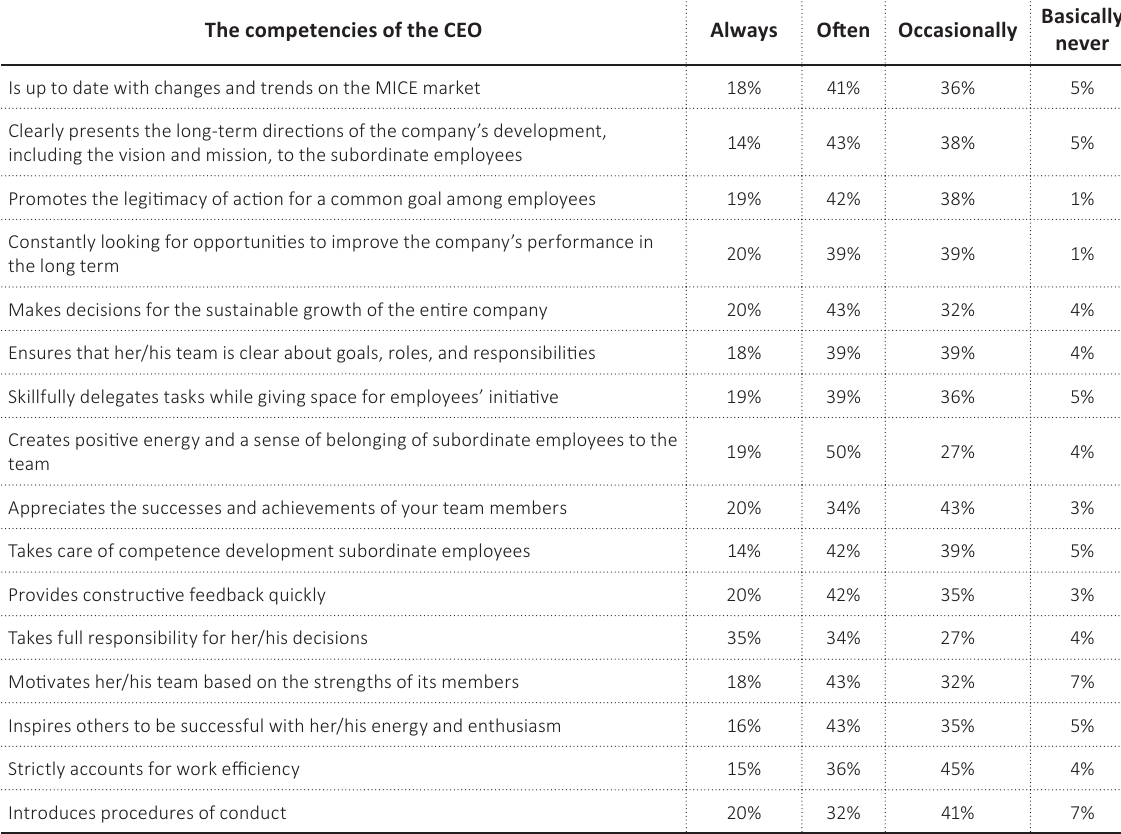
Table 7. Assessment of the competencies of the CEO